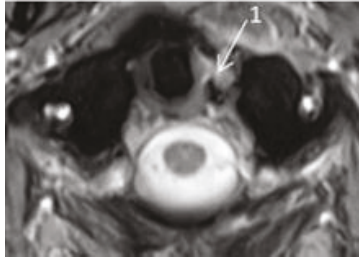
Figure 6: Cervical MRI coronal view. Dens (1), right occipital condyle (2), right C1 lateral mass (3), left occipital condyle, left C1 lateral mass. Note the bilateral edema in the right atlantooccipital joints (A) and the edema in the C1 – C2 re fl ect mild capsular disruption.